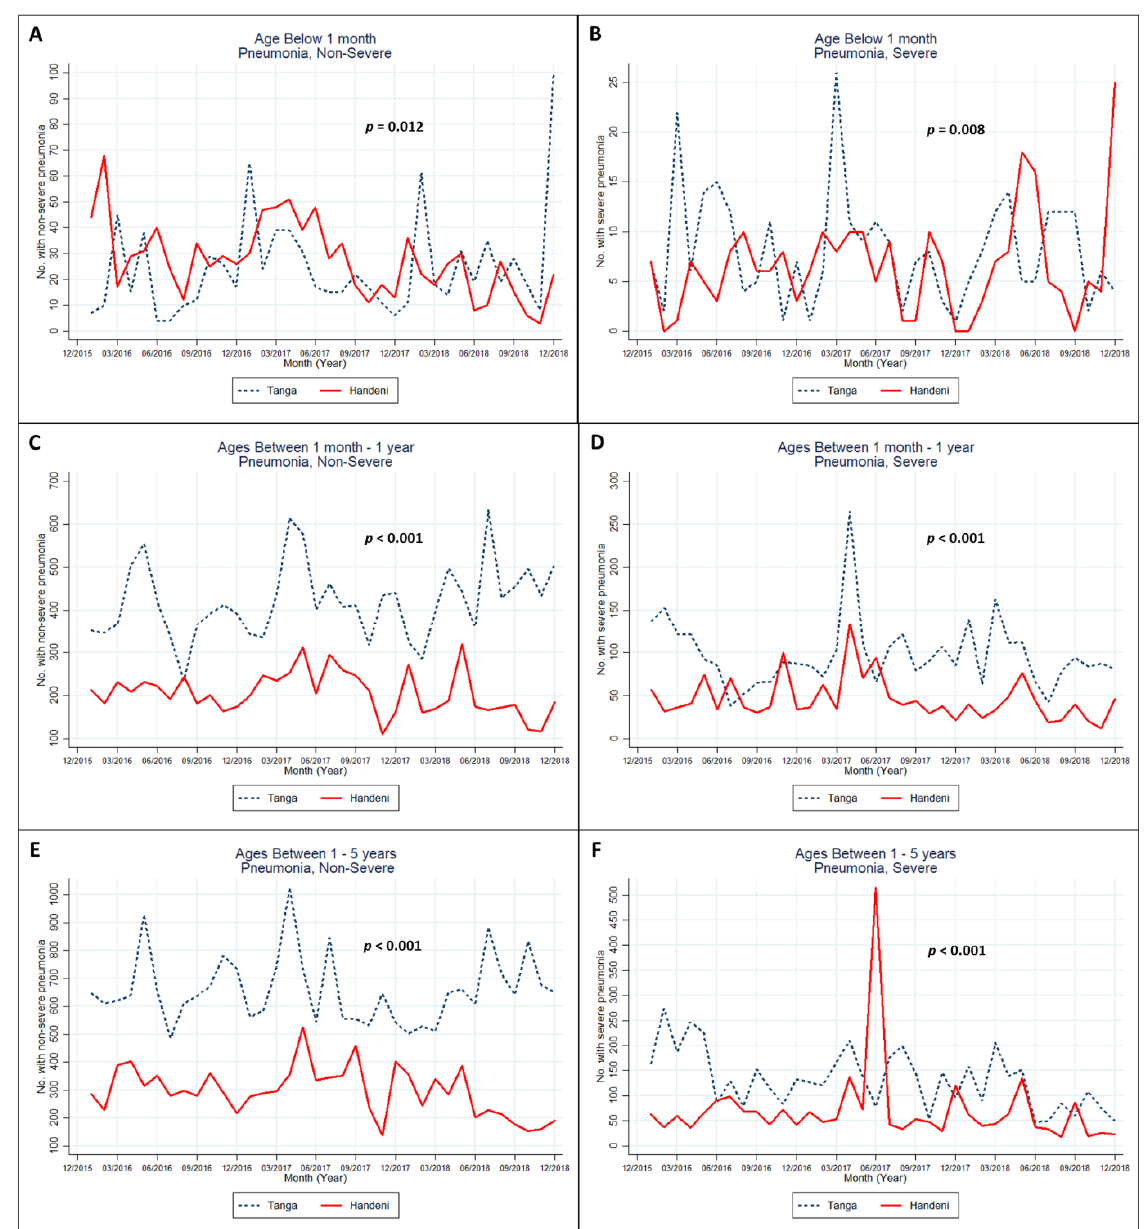
Figure 2. Monthly non-severe ( A , C , E ) and severe ( B , D , F ) pneumococcal infections in children under five from 2016 to 2018 in Tanga, Tanzania. Note : multilevel mixed-effects Poisson regression—with levels 1 and 2 being month and year, respectively—was used to test the trend differences .